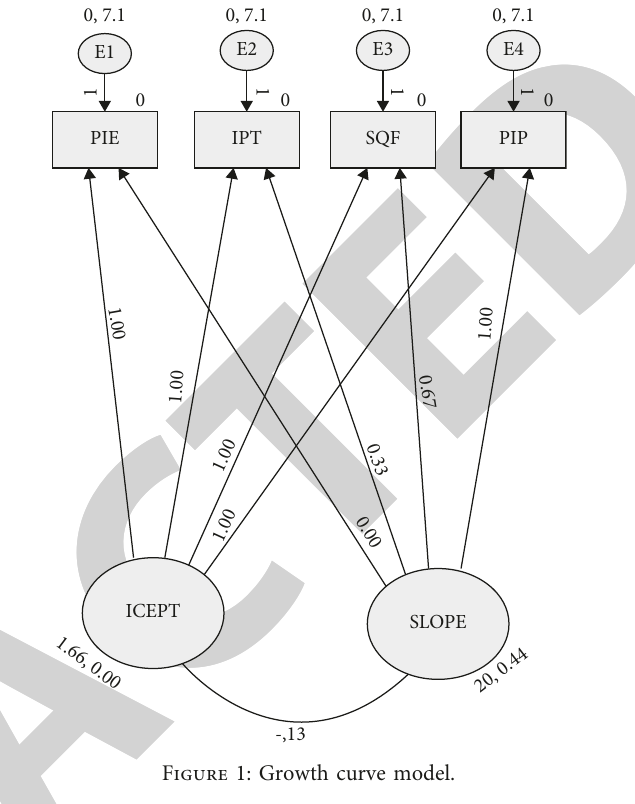
Figure 1: Growth curve